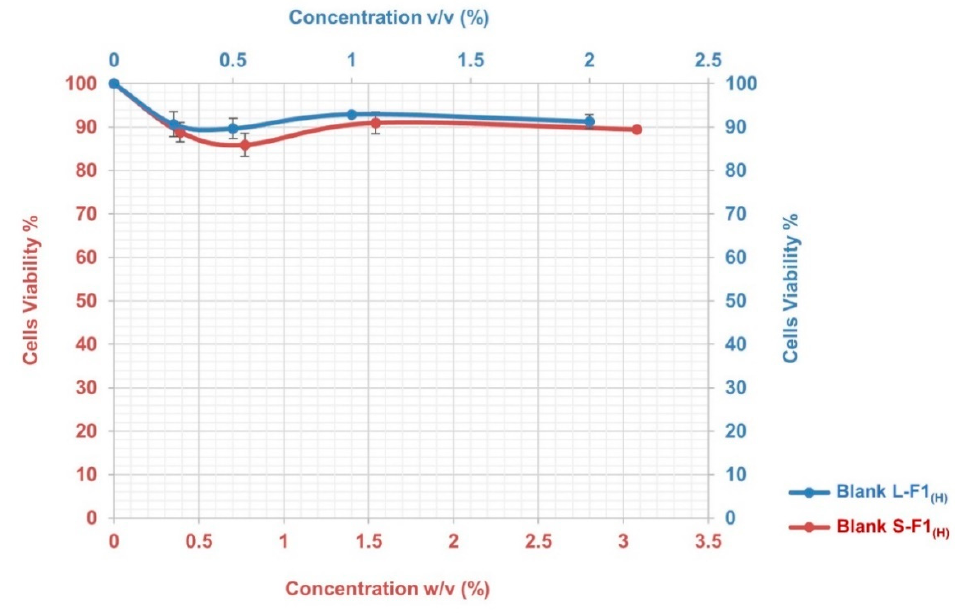
Figure 5. The cytotoxicity profile of Blank L-F1 (H) , and Blank S-F1 (H) formulations at different concentrations. Mean ± SEM, n = 3.